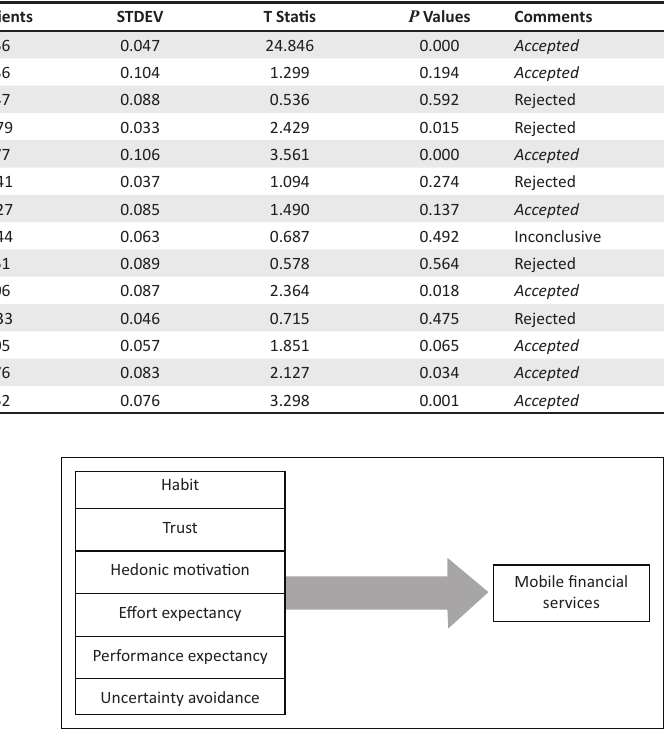
FIGURE 2: Empirical findings of factors influencing bottom of the pyramid’s adoption of mobile financial services in South African